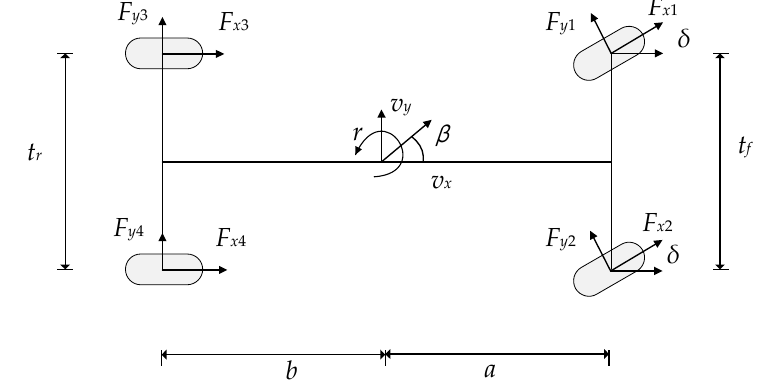
Figure 1. Dual-track vehicle dynamic